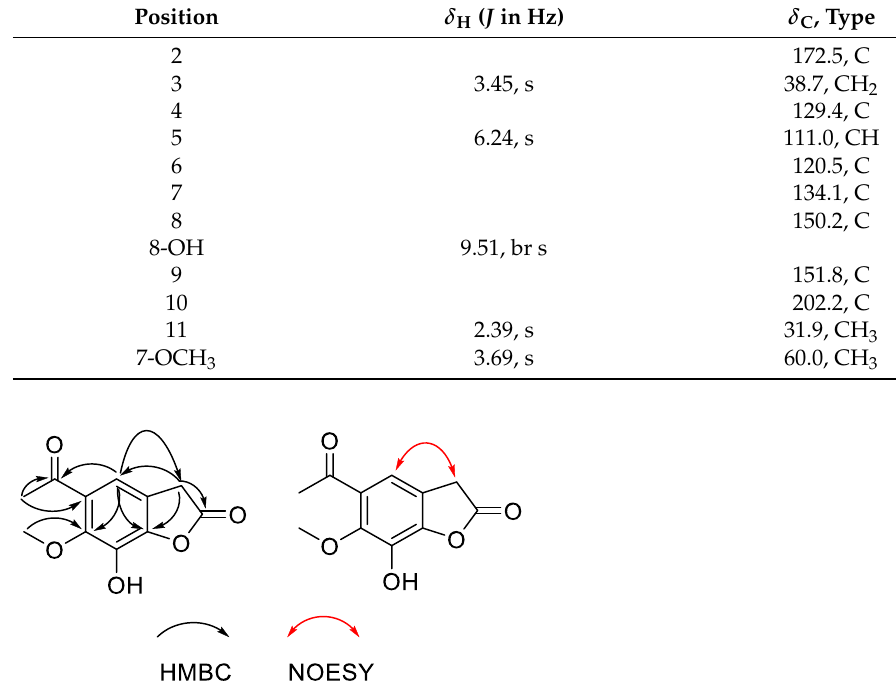
Figure 2. HMBC (single arrows) and NOESY (double arrows) correlations for compound 1 . Compound 2 was isolated as a white powder with the molecular formula of C 10 H 13 NO 2 as derived from the HRESIMS ion at m / z 180.1017 [M + H] + (calculated for C 10 H 14 NO 2 , 180.1019). The IR absorption bands at 3437 and 1026 cm −1 indicated hydroxy and carbon-nitrogen bonds. The 1 H NMR spectrum of compound 2 revealed the presence of two methyl protons ( δ H 1.25 and 1.22), two ortho-coupled aromatic protons ( δ H 6.69, d, J = 8.2 Hz and 7.77, d, J = 7.7 Hz), one aromatic proton ( δ H 7.79, s), one methylene ( δ H 3.17, dd, J = 8.9, 4.5 Hz) and one oxygenated aliphatic methine ( δ H 4.63, t, J = 8.8 Hz) (Table 2). The 13 C NMR spectrum display 10 carbon signals, including three quaternary C-atoms ( δ C 163.8, 128.2, 72.5), two methyls ( δ C 25.1, 25.3), one methylene ( δ C 31.1) and four methines ( δ C 131.4, 127.5, 108.9, 91.1) (Table 2). Analysis of the hydrogen and carbon quantities obtained from